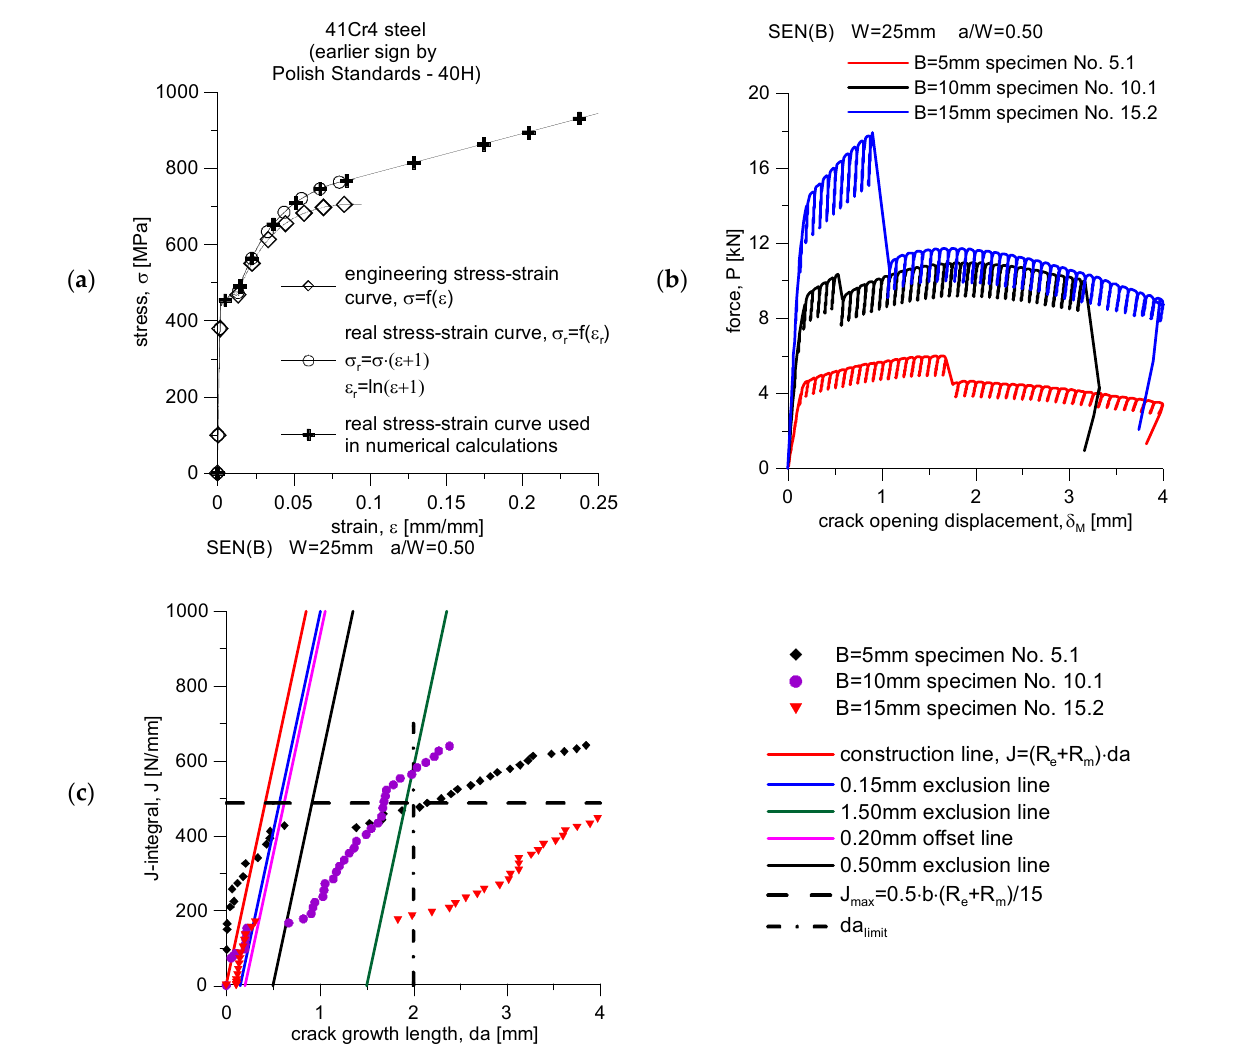
Figure 1. ( a ) The engineering and real tensile curve of 41Cr4 steel, prepared for the needs of numerical FEM calculations [6]. ( b ) Selected diagrams of force, P, as a function of crack mouth displacement, δ M , for steel 41Cr4, recorded using SEN(B) specimens [5,6]. ( c ) The J ‐ R curves obtained while determining the fracture toughness of 41Cr4 steel—selected results [5,6].